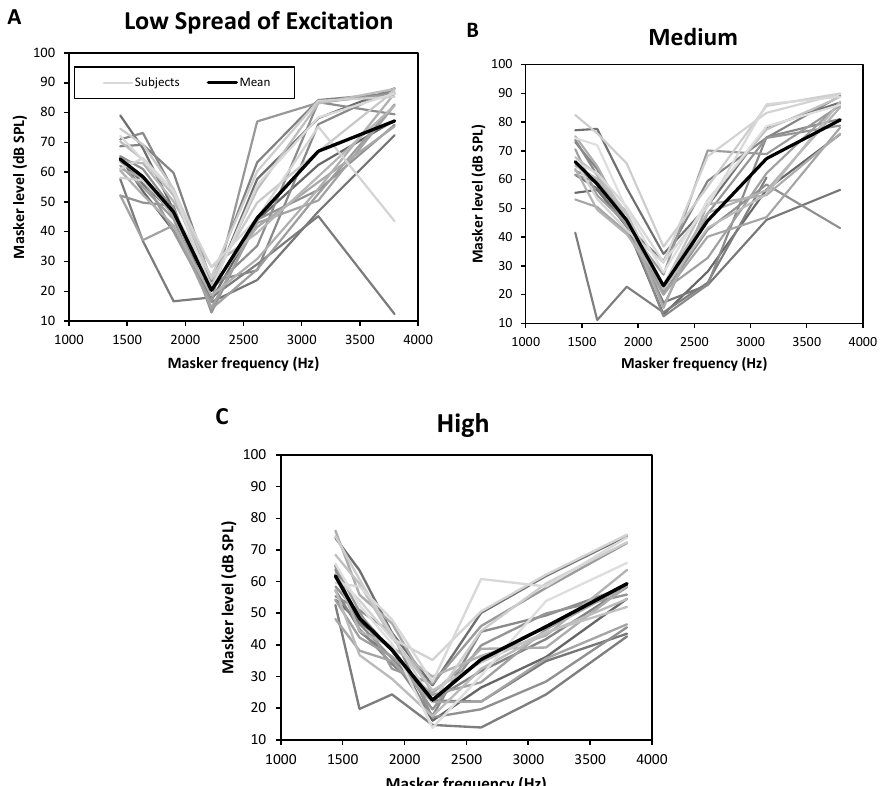
Figure 4. Measured psychophysical tuning curves (PTC). Masking thresholds (in dB SPL) function of the masker frequency (fm = 1440.5, 1637, 1898.5, 2226, 2619, 3143 and 3798 Hz). Each subject is represented by a different grey curve and the average curve is in black with white dots. ( A ) PTCs for “Low” spread of excitation. ( B ) PTCs for “Medium” spread. ( C ) PTCs for “High” spread.